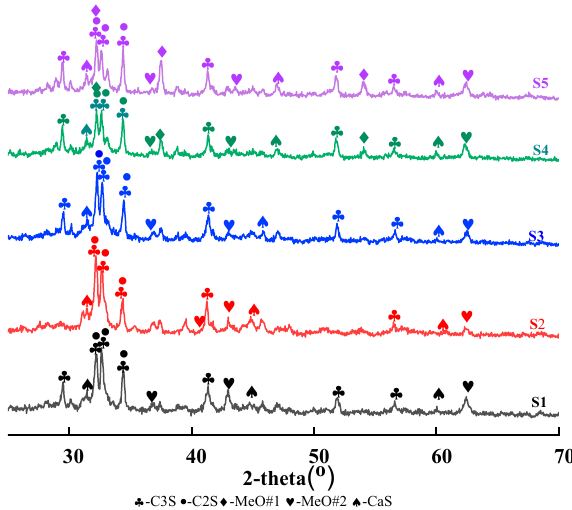
Figure 5. XRD diagram of synthetic slags with different basicities.